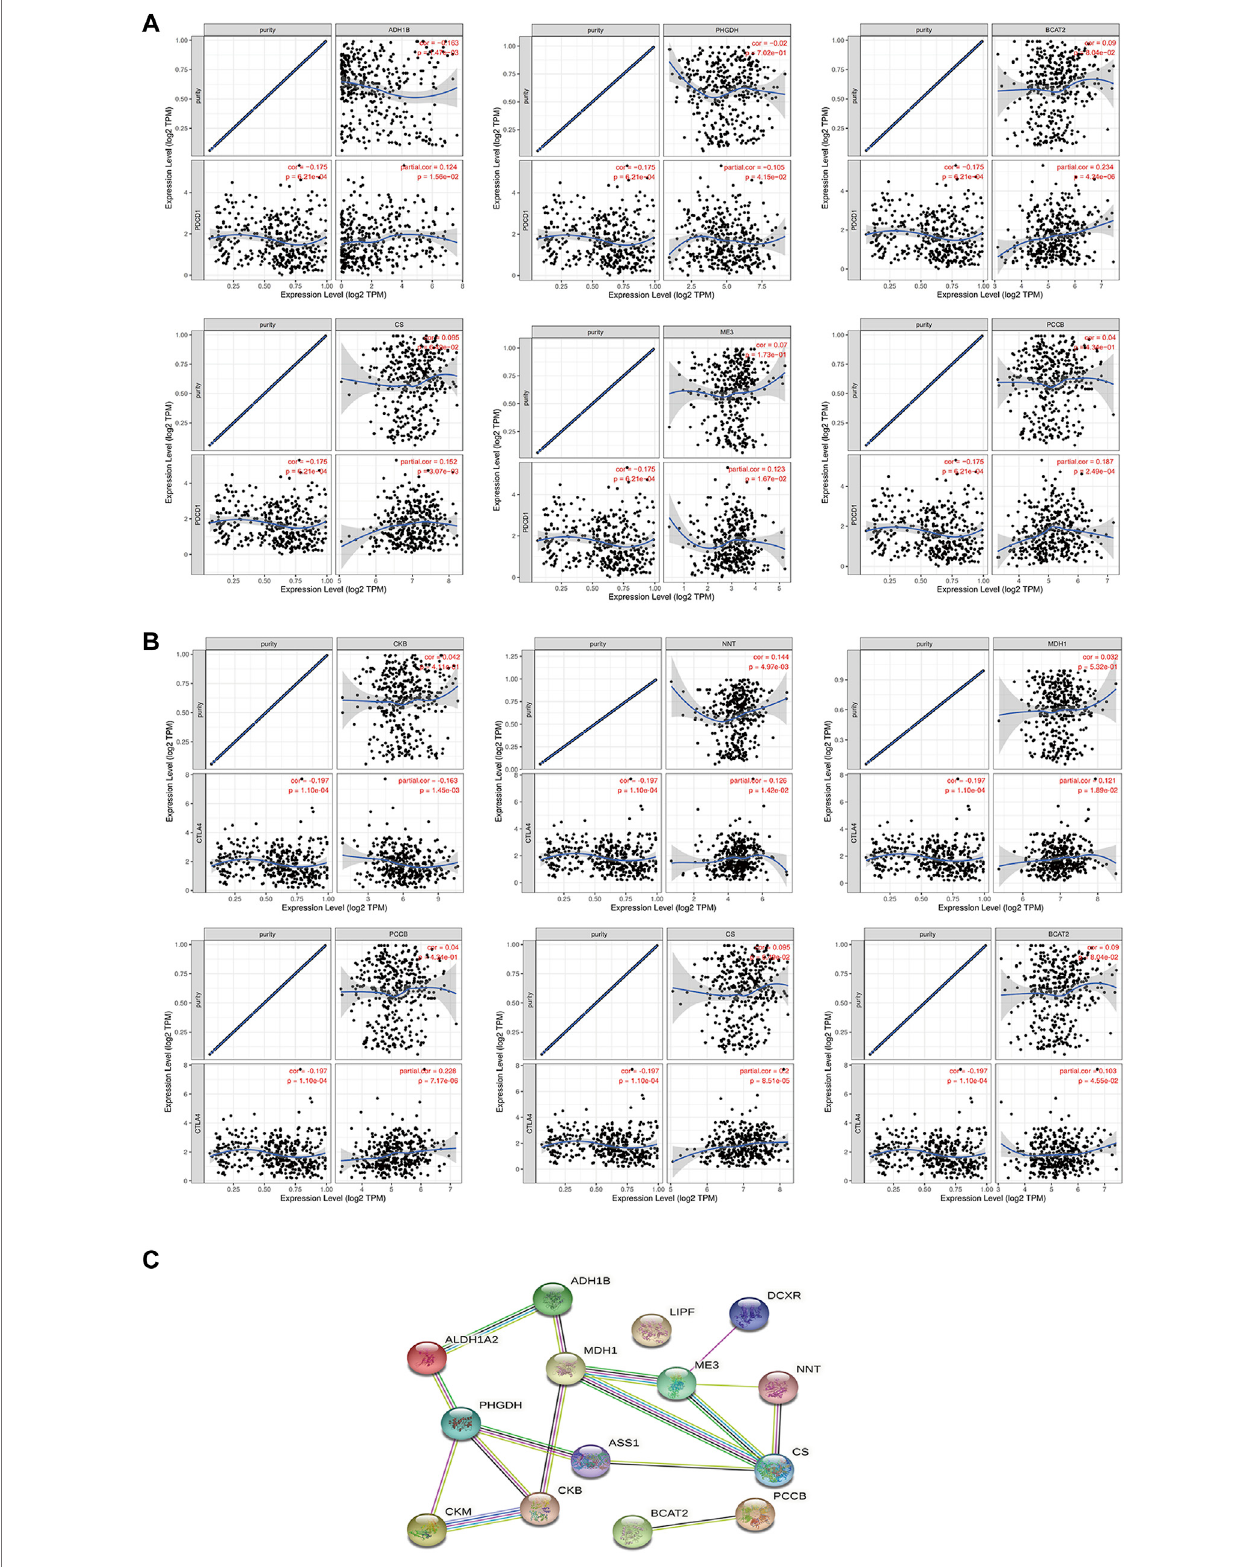
FIGURE 4 | Analysis of the correlation between 14 metabolic genes and PD-1/CTLA4. (A – B) Correlation analysis of 14 metabolic genes and PD-1/CTLA4 in the TIMER database. (C) PPI network constructed by 14 metabolic genes in STRING.